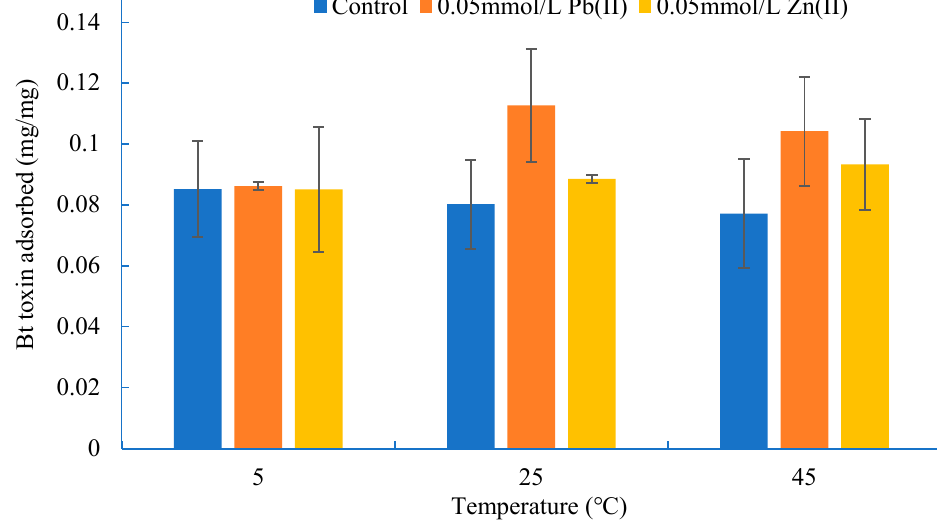
Figure 3. Adsorption of Bt toxin in black soil at different temperatures.